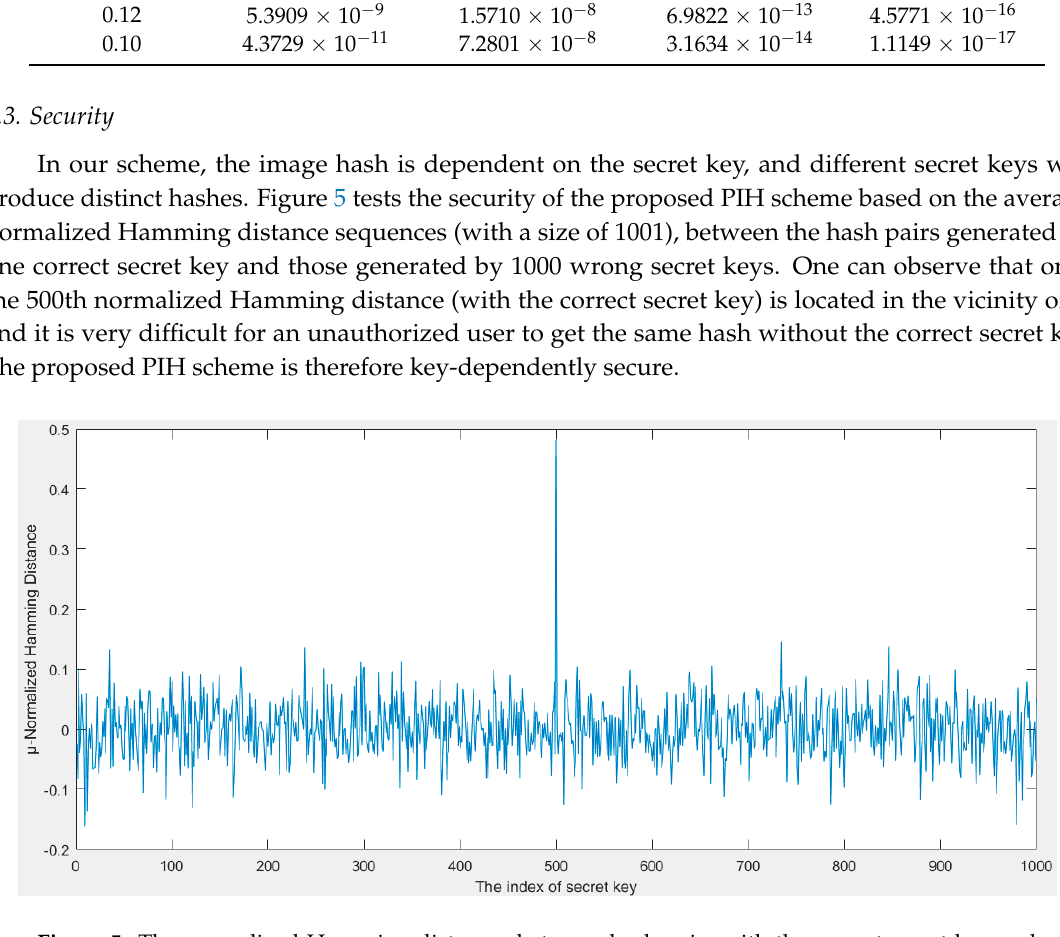
Figure 5. The normalized Hamming distances between hash pairs with the correct secret key and 1000 wrong secret keys.